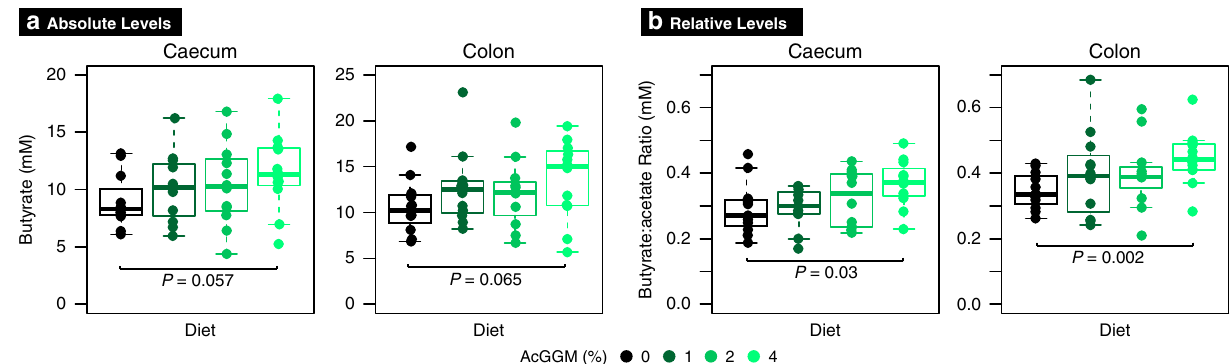
Fig. 2 Butyrate detected in the cecum and colon digesta of pigs fed the four different AcGGM diets with varying inclusion levels (0 – 4%). a display absolute levels and b relative levels of butyrate. Raw SCFA measurements are presented in Supplementary Data 1. Bars represent median and boxes interquartile range determined from 12 animals analyzed per dietary group. Data were analyzed using a two-tailed t -test, with p -values indicated between pigs fed either the control or 4% AcGGM diets. The boxes span the 25th – 75th percentiles with the central bars being the medians. Whiskers extend maximum up to 1.5× the interquartile range (IQR) or, when all values are within 1.5× IQR, then the whisker extends to the most extreme data